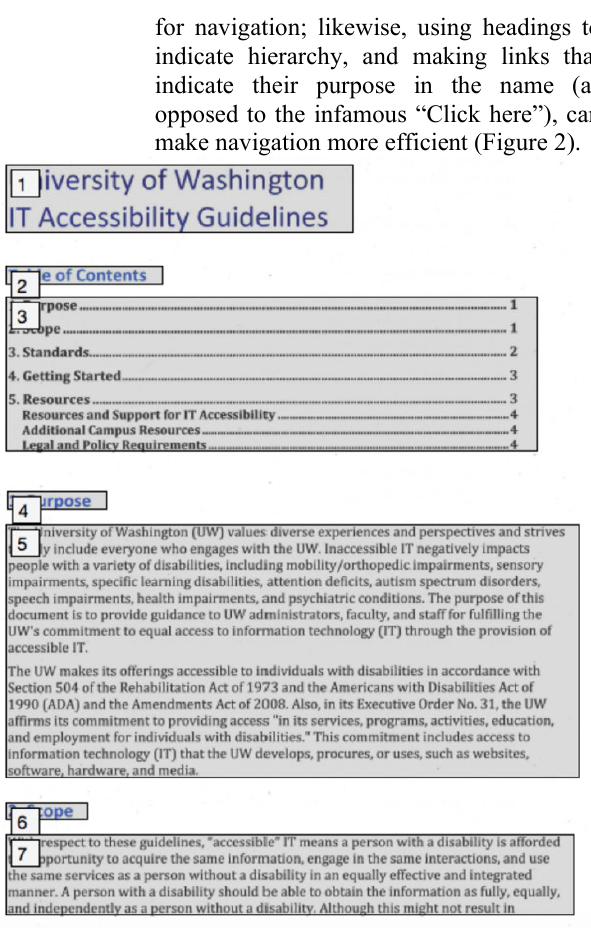
Figure 2. Example of reading order based on the visual position of the elements on the page. Source